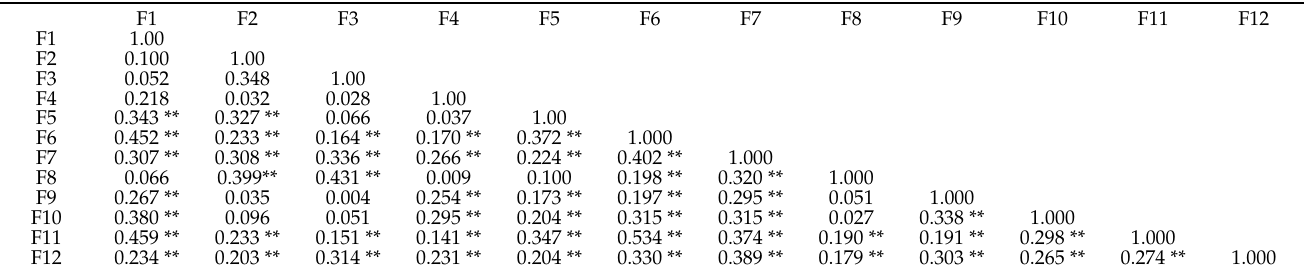
Table 3. Correlation coefficients for first-order factors.